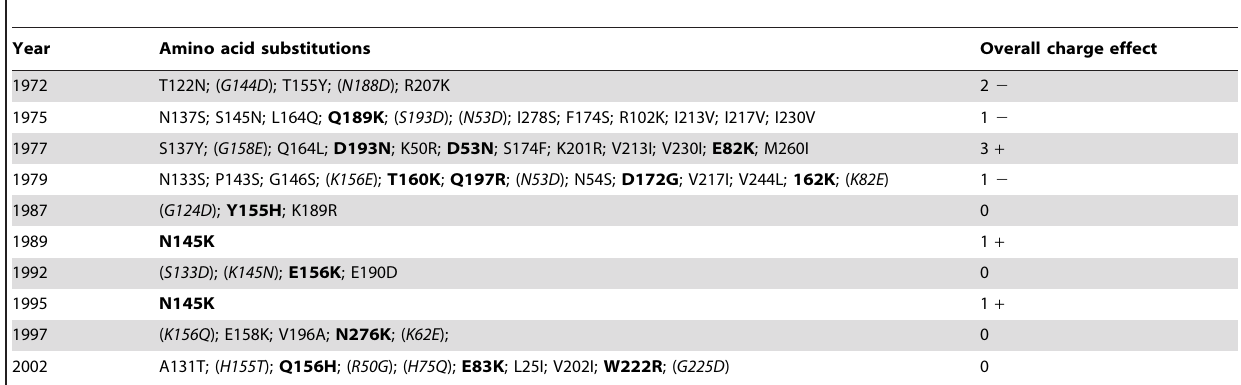
Table 2. Amino acid substitutions accompanying antigenic jumps, and their associated charge changes (see